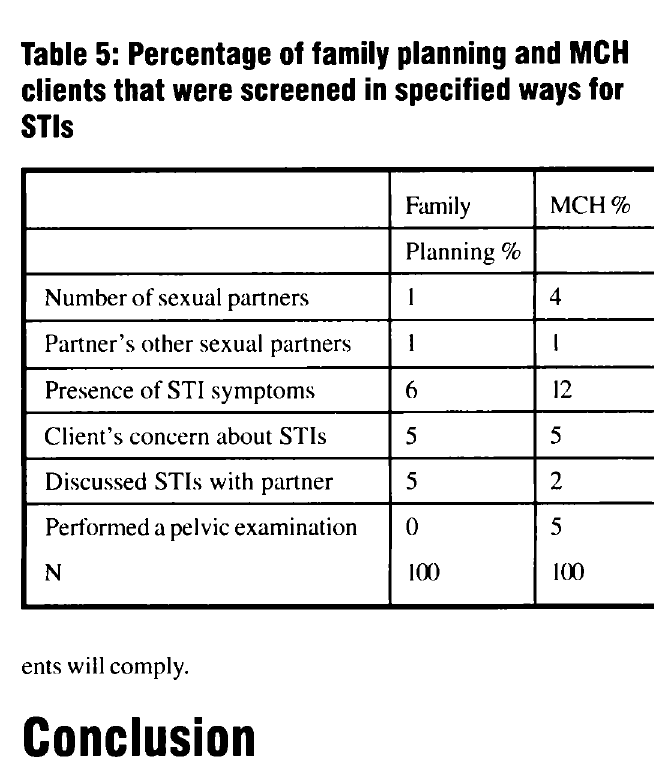
Table 5: Percentage of family planning and M CH clients that were screened in specified ways for STIs